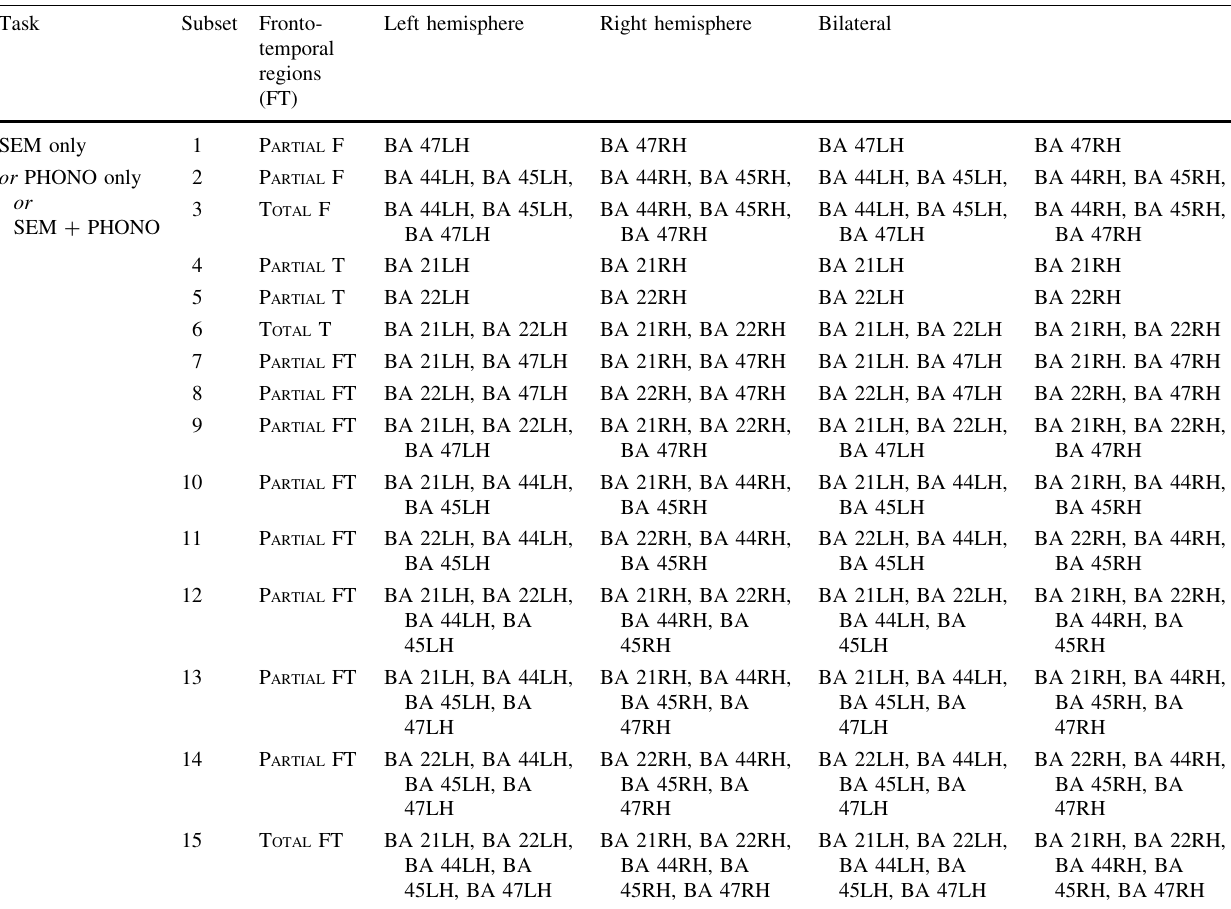
Fifteen subsets were based on combinations of fronto-temporal (FT) regions according to hemisphere and task and defined as follows: (a) only frontal regions (partial subsets 1–2 and total subset 3); (b) only temporal regions (partial subsets 4–5 and total subset 6), and (c) combination of frontal and temporal regions (partial subsets 7–14 and total subset 15). These subsets were evaluated for three thematic sets according to task (semantic only, SEM only; phonological only, PHONO only; semantic and phonological combined, SEM ? PHONO) and hemisphere (left hemisphere, right hemisphere and bilateral—both hemispheres)